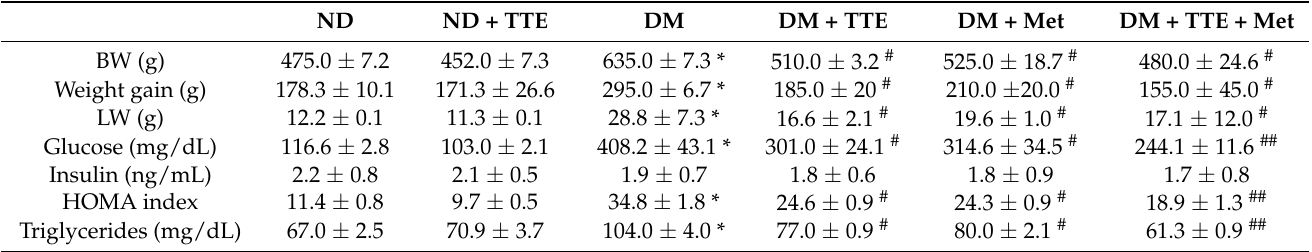
Table 3. The effect of TTE on general characteristics and plasma parameters in type 2 diabetes mellitus (T2DM) rats.